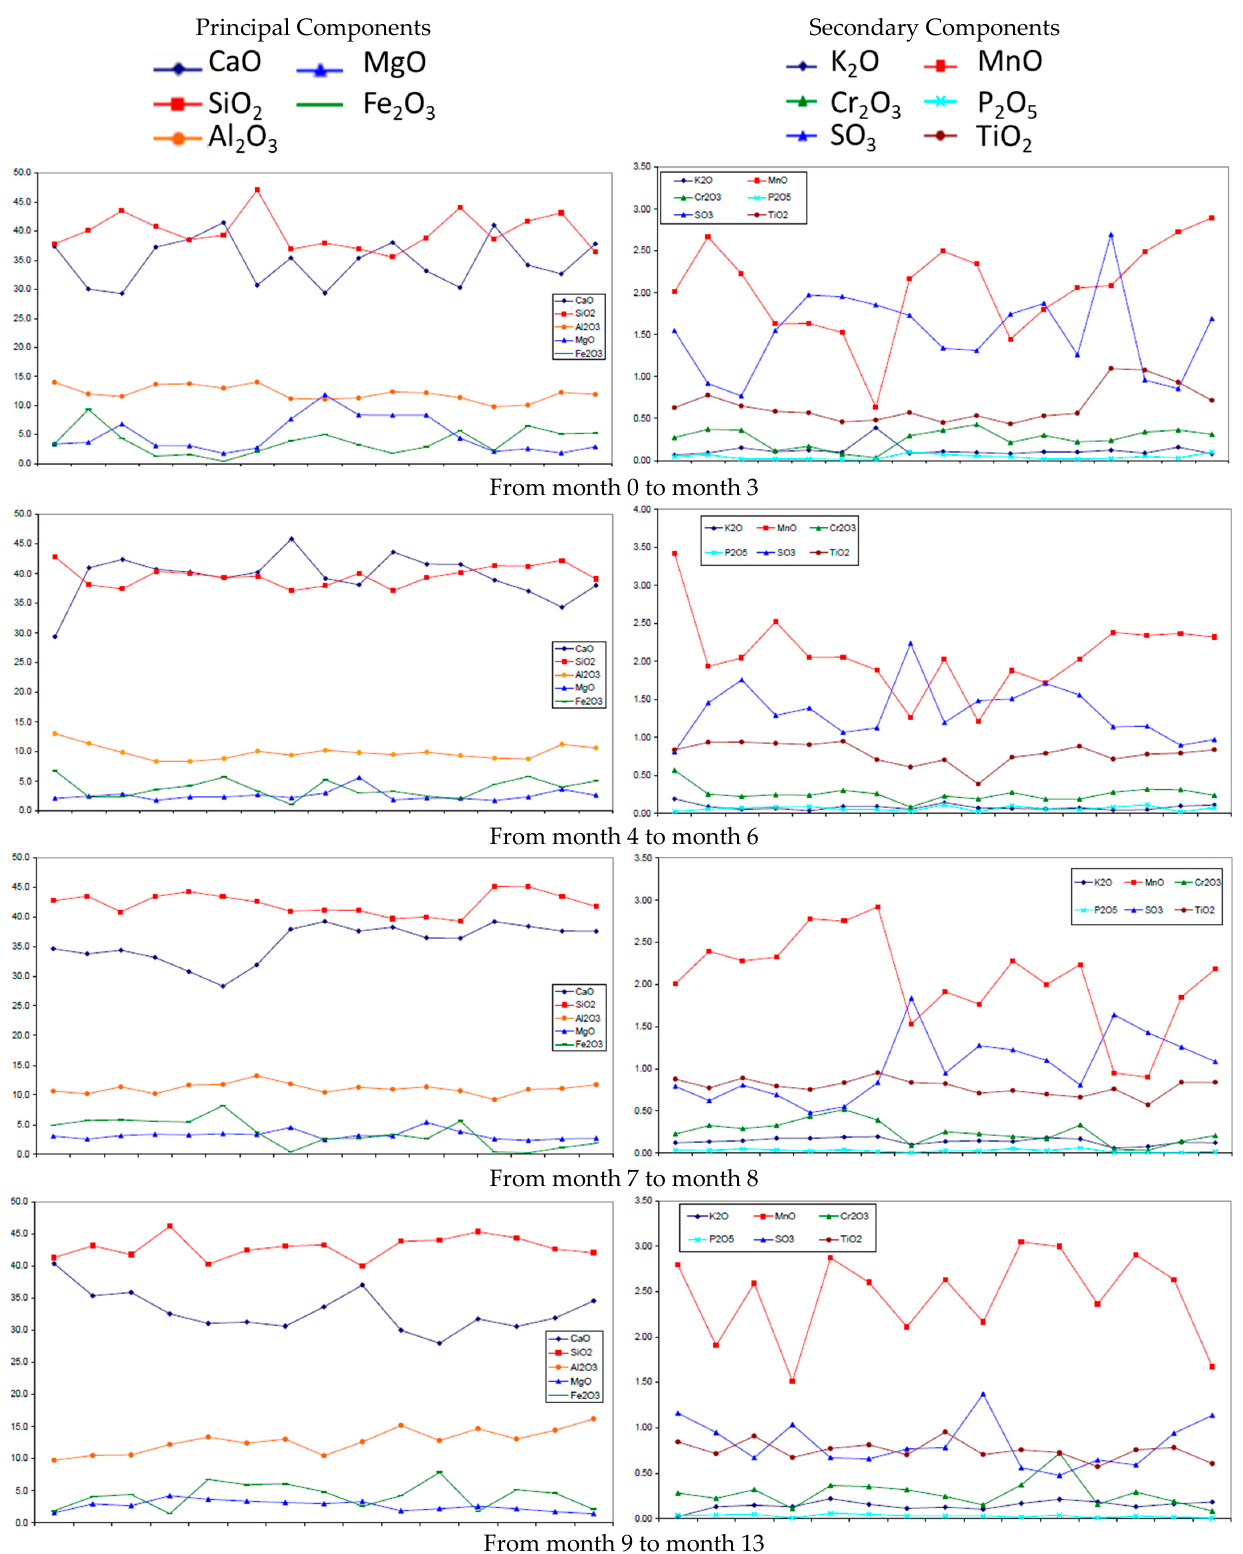
Figure 8. Cupola slag chemical composition stability (% wt.).